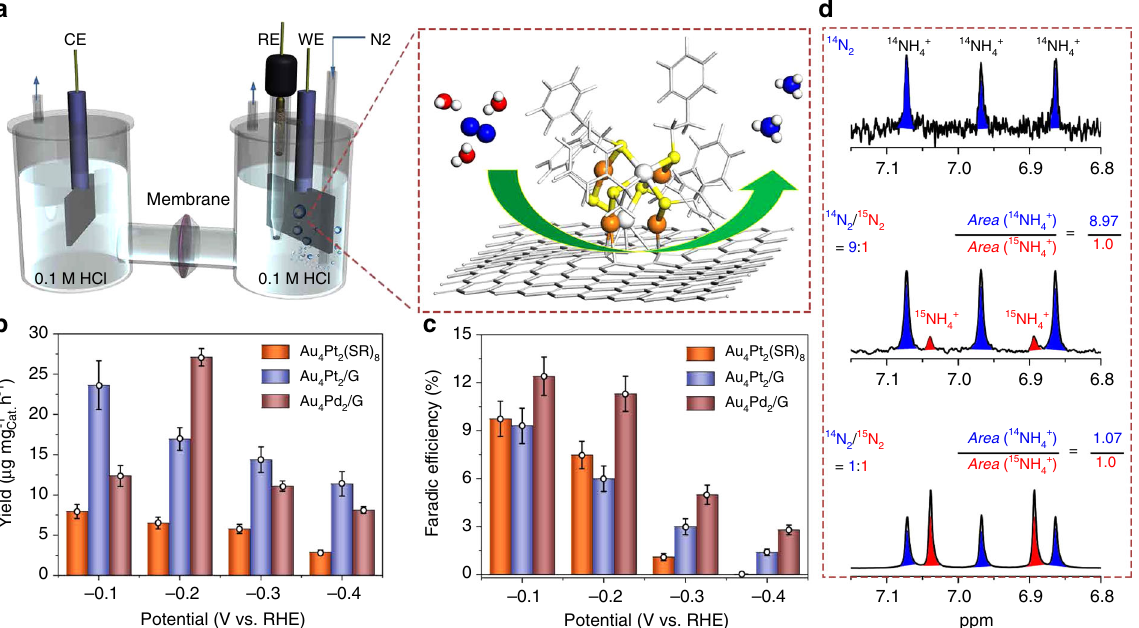
Fig. 3 Electrochemical N 2 reduction reaction using different catalysts. a Schematic illustration of the experimental setup for ENRR. b NH 3 production rate. c Faradic ef fi ciency of ammonia production at different potentials. d 1 H-NMR spectra of 14 NH 4 + and 15 NH 4 + produced from ENRR with different ratios of 14 N 15 N 2 / 2 as initial gas source, including pure determined to be 9:1 and 1:1, which are proportional to the initial ratio of 14 N 2 / 15 N 2 gas. The error bars in b – c denote standard deviation of three technical